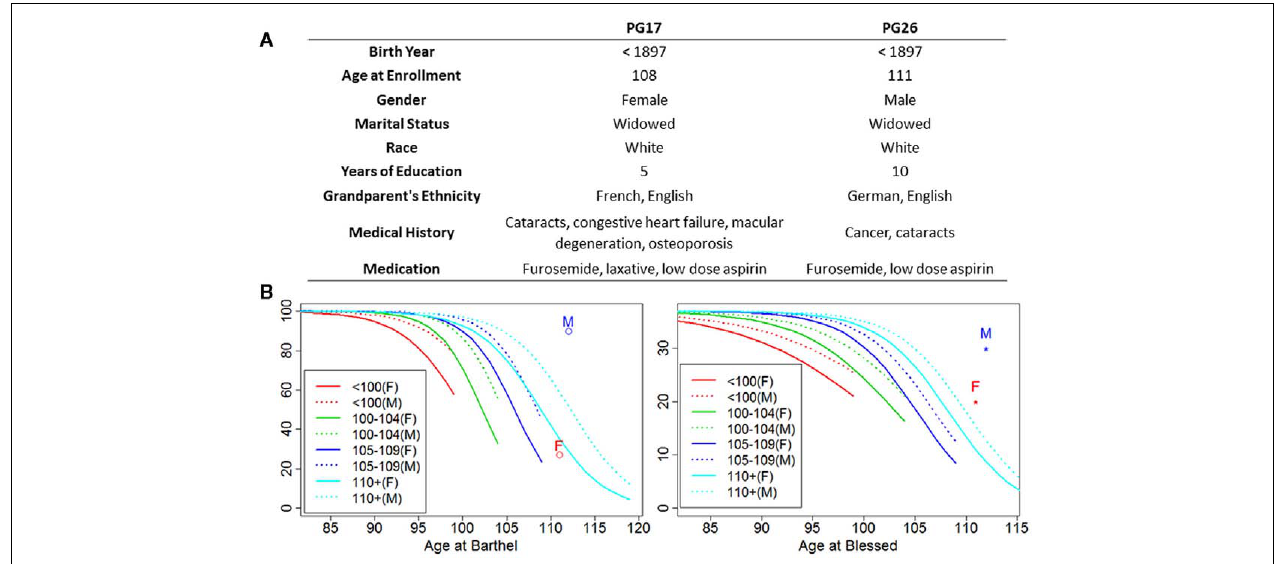
cognitive status of the two subjects relative to other NECS subjects (M = PG26 and F = PG17).The trajectories of physical and cognitive functional declines were computed using Bayesian logistic regression of Barthel and Blessed score as explained in Andersen et al. (2011) and